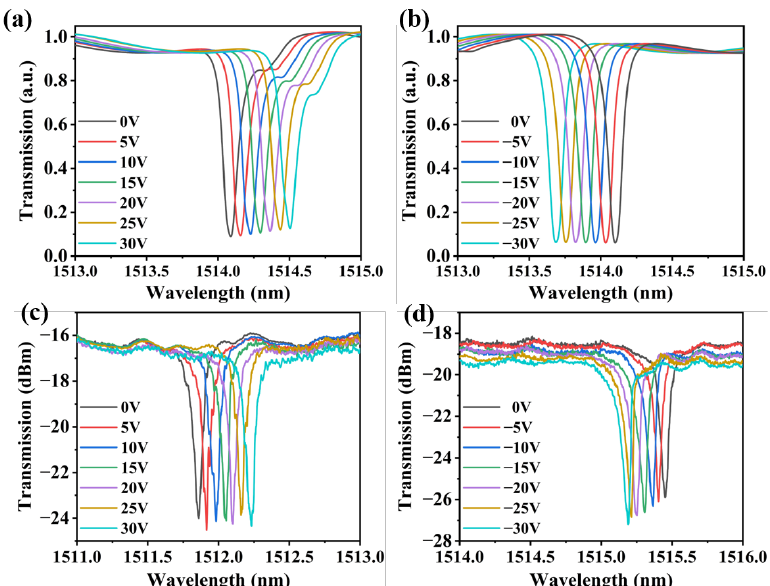
Figure 3. Microring resonator DC electro-optical modulation. ( a ) Simulation results of adding positive voltage modulation. ( b ) Simulation results of adding negative voltage modulation. ( c ) Positive voltage modulation experimental spectrum. ( d ) Negative voltage modulation experimental